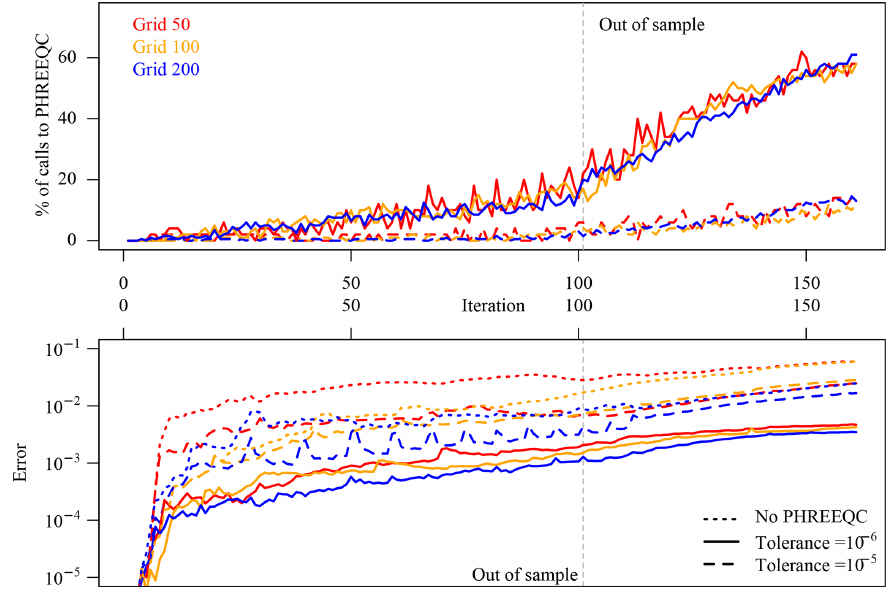
Figure 3. Purely data-driven approach: evaluation of calls to full-physics simulator for the runs with hierarchical coupling for the three discretizations at 50, 100, and 200 elements and of overall discrepancy between surrogate simulations and the reference. When the surrogate enters the region of “unseen data”, its accuracy degrades significantly, which causes loss of efficiency rather than accuracy.